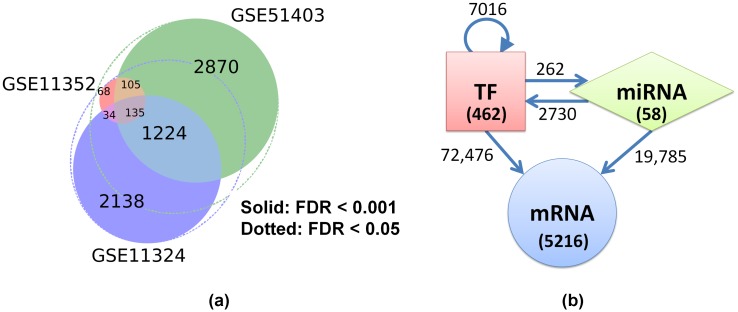
MCF-7 estrogen response gene network.(a) Differentially expressed genes with FDR < 0.001 were selected from two high quality datasets GSE11324 (microarray) and GSE51403 (RNA-seq). A significant number of genes were common between the two datasets, near about 70% if a FDR cutoff of 0.05 were to be used as shown by dotted ellipses. The union list between GSE11324 and GSE51403 was selected for network construction. The union list also had a good overlap with another dataset GSE11352. (b) The final MCF-7 network consisted of 5736 nodes including 462 TFs, 58 miRNAs and 5216 mRNA genes. The numbers on the edges denote the total number of interconnections between various types of nodes.